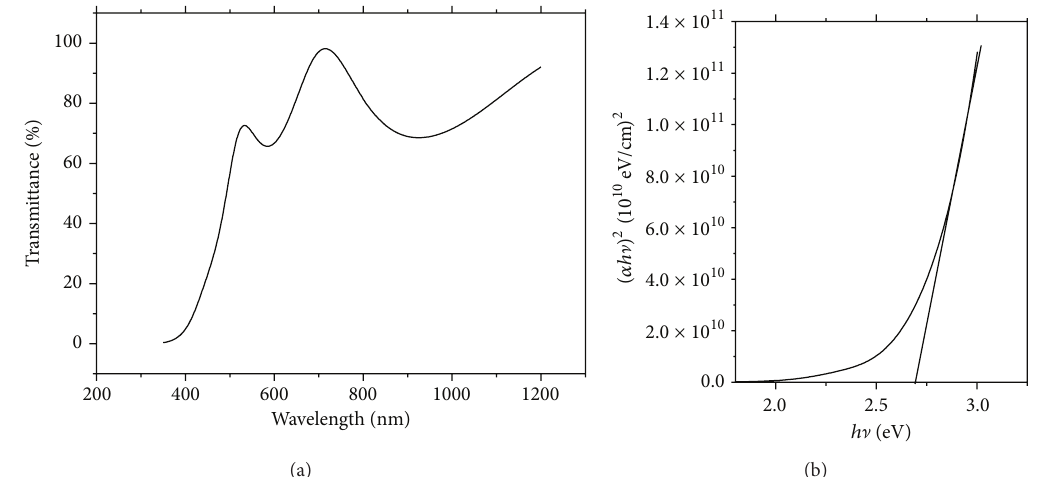
Figure 4: Optical transmittance spectrum (a) and the band gap (b) of sample IS3.